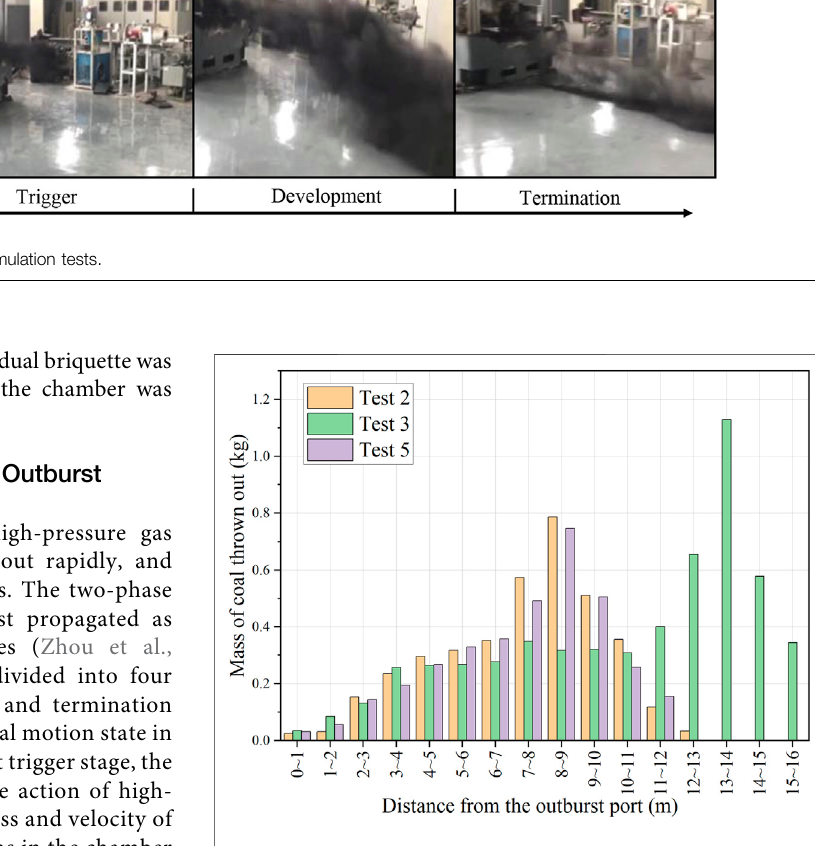
FIGURE 8 | Mass distribution of coal powder at different